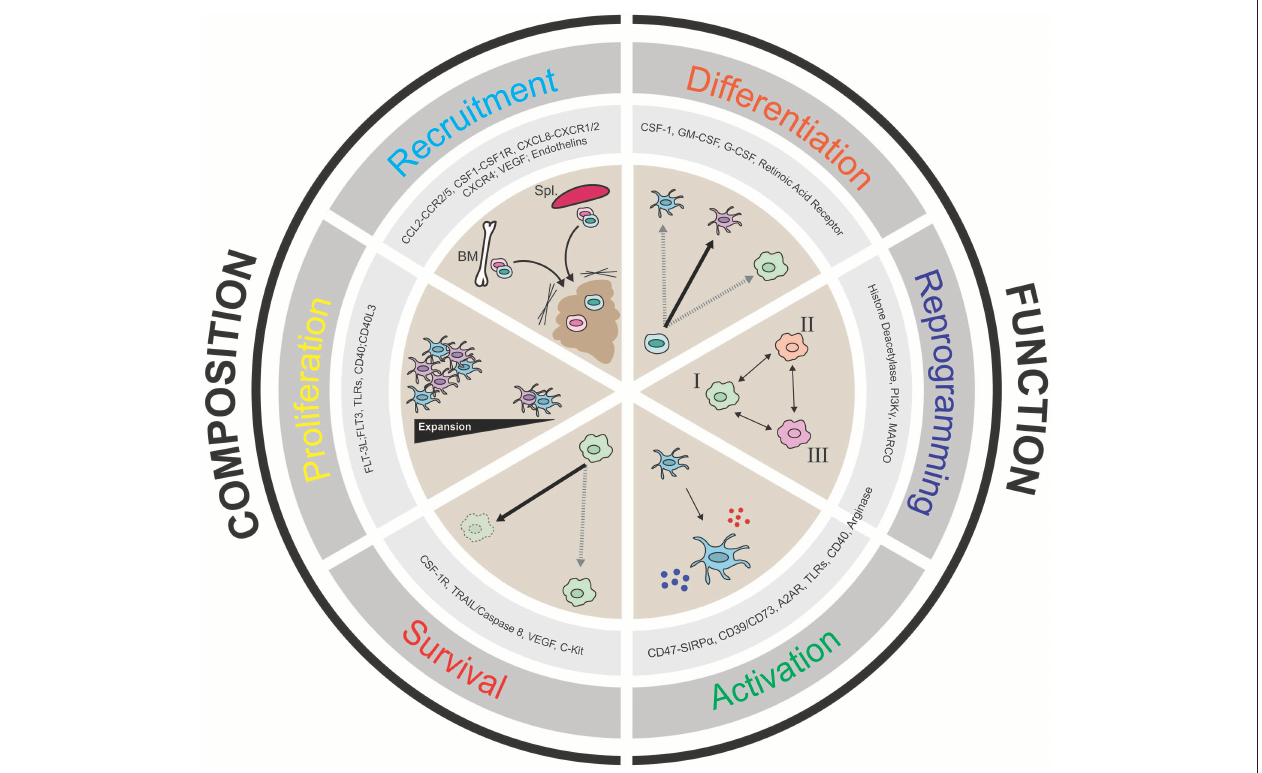
FIGURE 2 | Cartoon depicting the six “Pillars of Myeloid Tuning” and the myeloid targets within each category. The myeloid tuning strategies affecting the Composition of the TME include targets modulating Recruitment (CCL2-CCR2/5, CSF1-CSF1R, CXCL8-CXCR1/2; CXCL12-CXCR4, VEGF-VEGFR, Endothelins), Proliferation (FLT3L-FLT3, TLRs, CD40-CD40L), and Survival (CSF1R, TRAIL/Caspase 8, VEGF, c-kit). The myeloid tuning strategies altering the Function of the TME include targets inducing Differentiation (CSF1, GM-CSF, G-CSF, Retinoic Acid Receptor ATRA), Reprogramming (Histone Deacetylase, CSF1R, MARCO, Arginase, PI3K γ ), and Activation (CD47-SIRP α , A2AR, CD73/CD39, STING, TLRs, CD40, Arginase). The indicated myeloid targets in each category are not